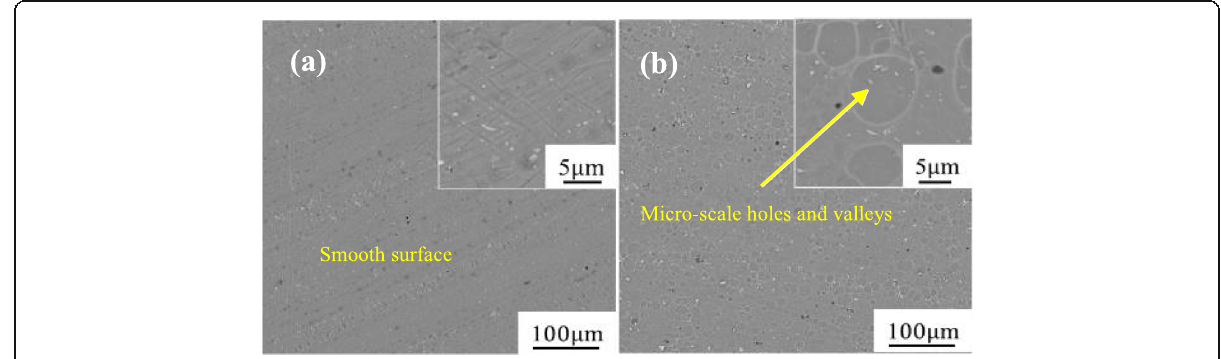
Fig. 5 SEM images of the Al surface after a degreasing and b alkali etching